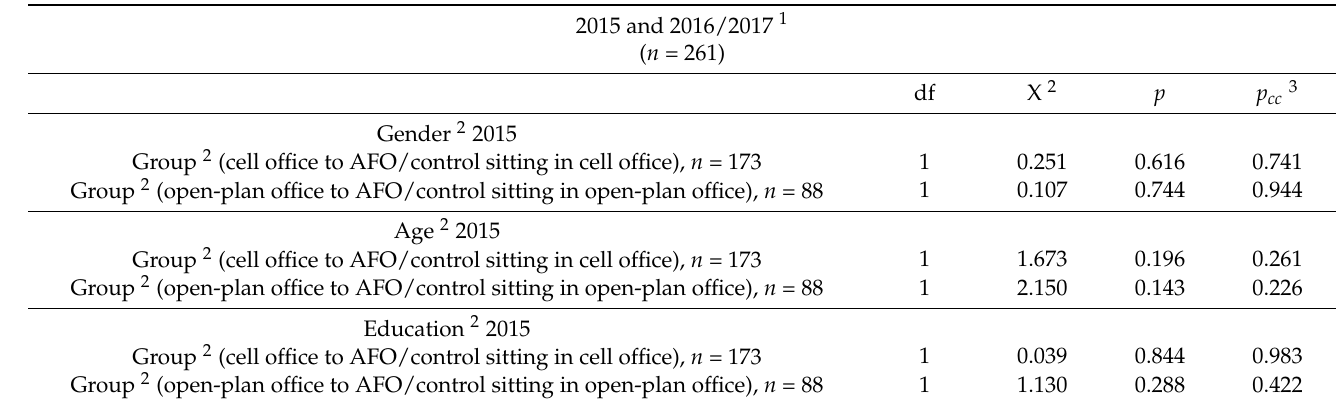
Table 3. Chi-square tests for the background variables of age, gender, and education in a comparison between intervention and control groups at the baseline measurement in